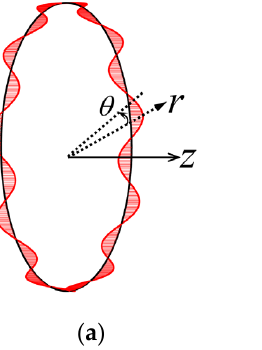
Figure 2. Schema of nodal diameter traveling wave vibration of rotating periodic structures: ( a ) Instantaneous axial displacement; ( b ) Axial displacement at different times.